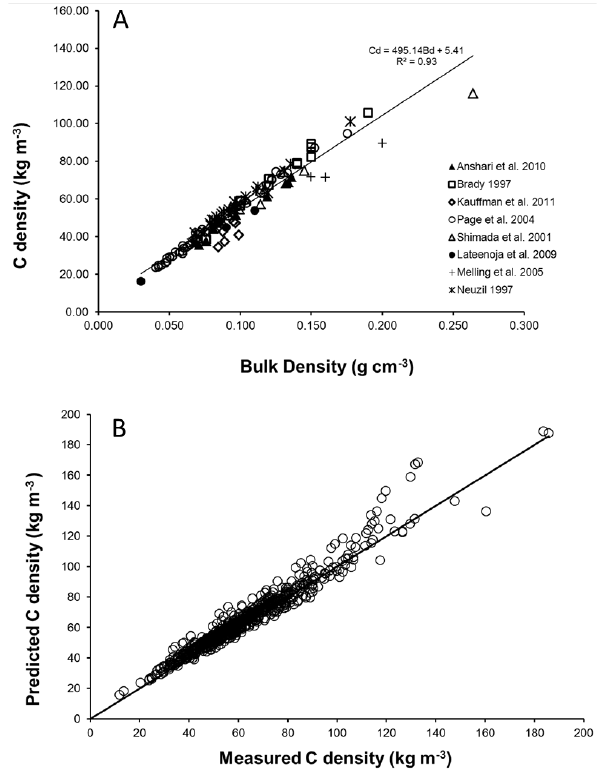
Fig. 1. (A) Linear relationship between C density and dry bulk density for peat soils > 40% derived from nine primary literature sources. (B) Predicted carbon density versus measured carbon den- sity, with 1:1 line for 591 peat samples collected in this study.